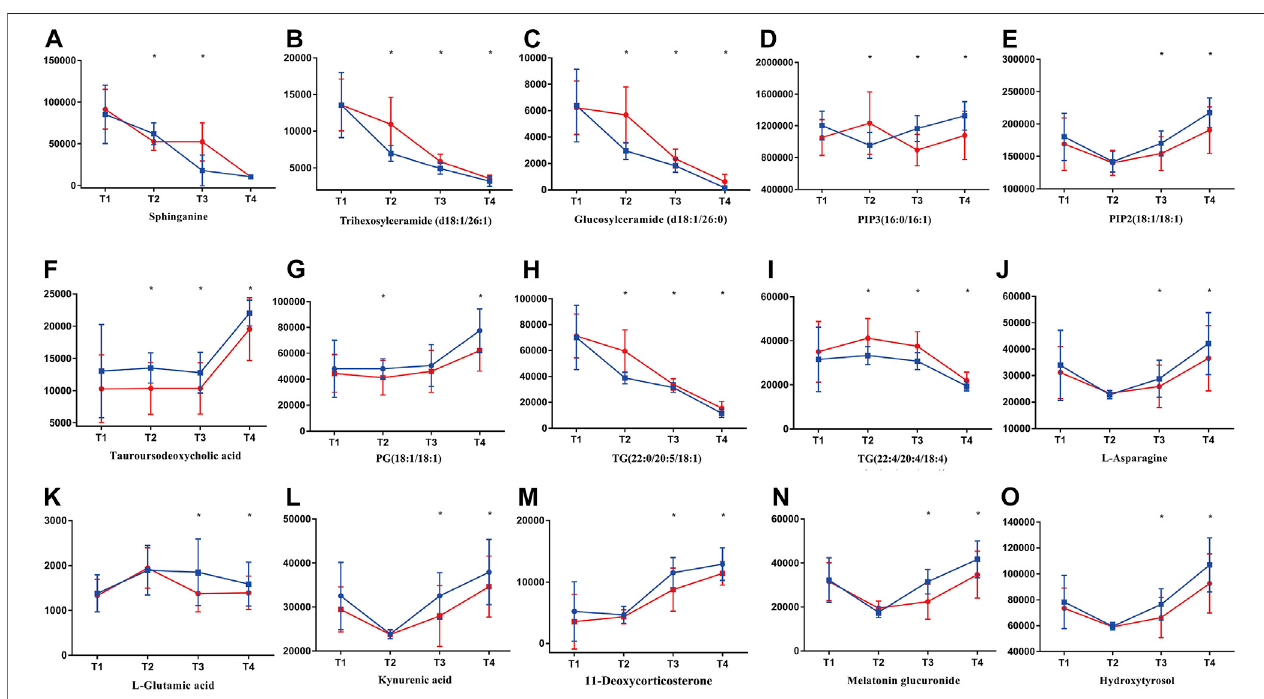
FIGURE7| Typicalmetaboliteswithsigni fi cantchangesinAMAsubgroup.Linesinblue( )representZYPgroupwhileinred( )representplacebogroup.Contents of metabolites were assessed with t test between ZYPand placebo group. Contents ofmetabolites are shown in this fi gure, i.e., (A) sphinganine, (B) trihexosylceramide (d18:1/26:1), (C) glucosylceramide(d18:1/26:0), (D) PIP3(16:0/16:1), (E) PIP2(18:1/18:1), (F) tauroursodeoxycholicacid, (G) PG(18:1/18:1), (H) TG(22:0/20:5/18:1), (I) TG(22:4/20:4/18:4), (J) L-asparagine, (K) L-glutamic acid, (L) kynurenic acid, (M) 11-deoxycorticosterone, (N) melatonin glucuronide, (O) hydroxytyrosol. * p < 0.05 were regarded as statistically signi fi cant, compared with placebo